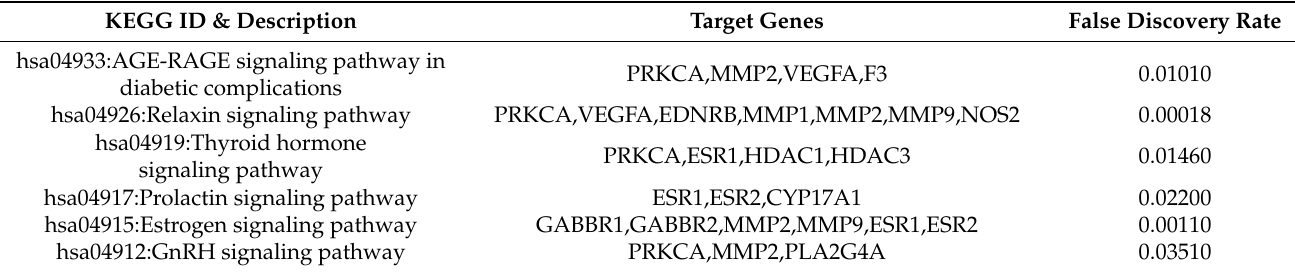
Figure 4. PPI networks (99 nodes, 469 edges). The size of the circle: degree of values. Table 4. Targets in 19 signaling pathways associated with